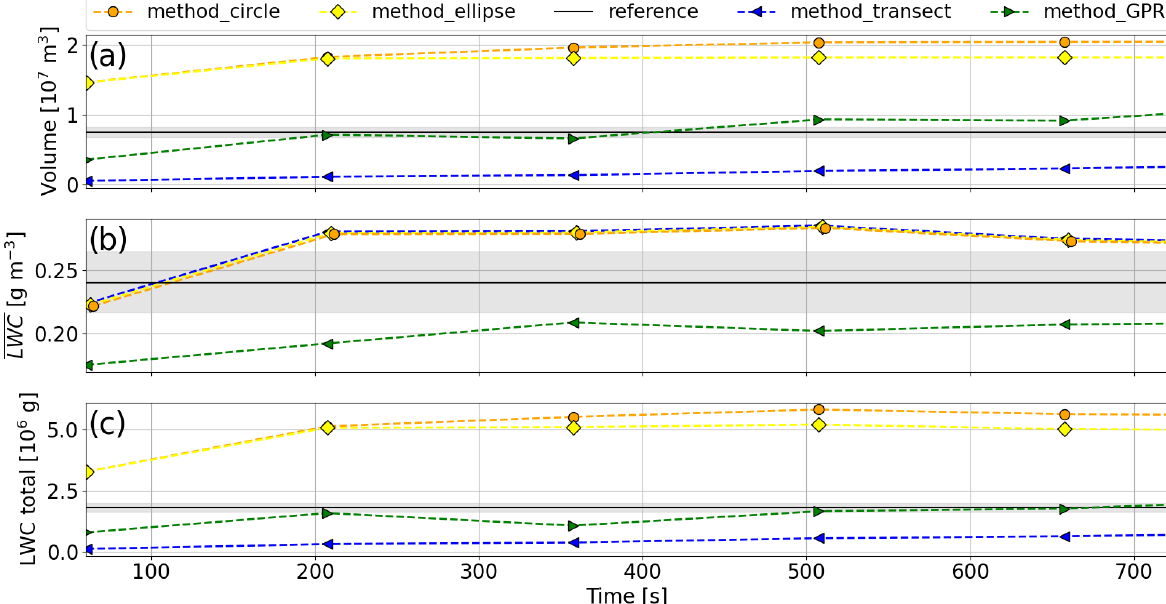
Figure 9. (a) Reconstructed cloud volume with circle method (orange line), ellipse method (yellow line), transect method (blue line), and GPR method (green line) compared to the reference volume (black line) for cloud N2 in static state at 700m for one exploration. (b) The blue line corresponds to LWC calculated by the transect method, the green line by the GPR method, and the dotted black line the reference LWC. (c) Same for integration of LWC in the section